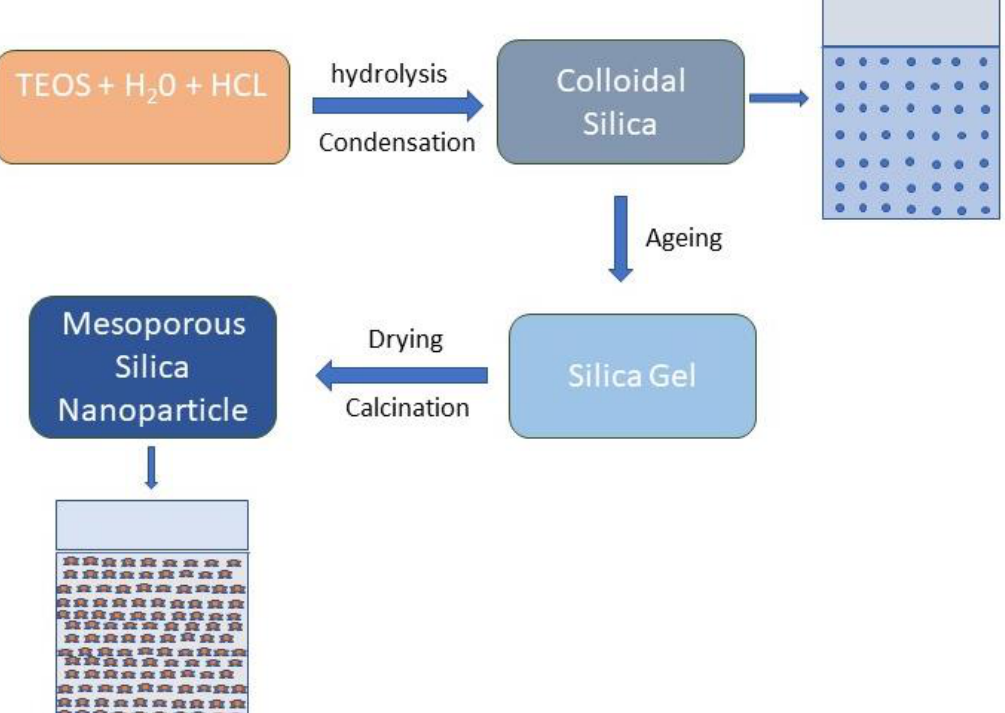
Figure 6. Sol-Gel process for the synthesis of Mesoporous Silica Nanoparticles.